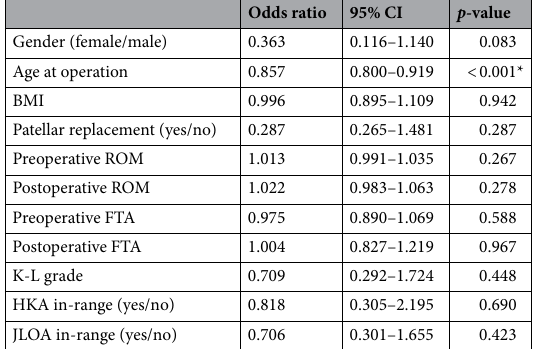
Table 4. A multivariate analysis for the factors associated with postoperative KS-FS > of 80 points. KS-FS, Knee Society Function Score; BMI, body mass index; ROM, range of motion; FTA, femorotibial angle; K-L, Kellgren-Lawrence; HKA, hip-knee-ankle axis; JLOA, joint line orientation angle; CI, confidence interval. *Significant difference, p <